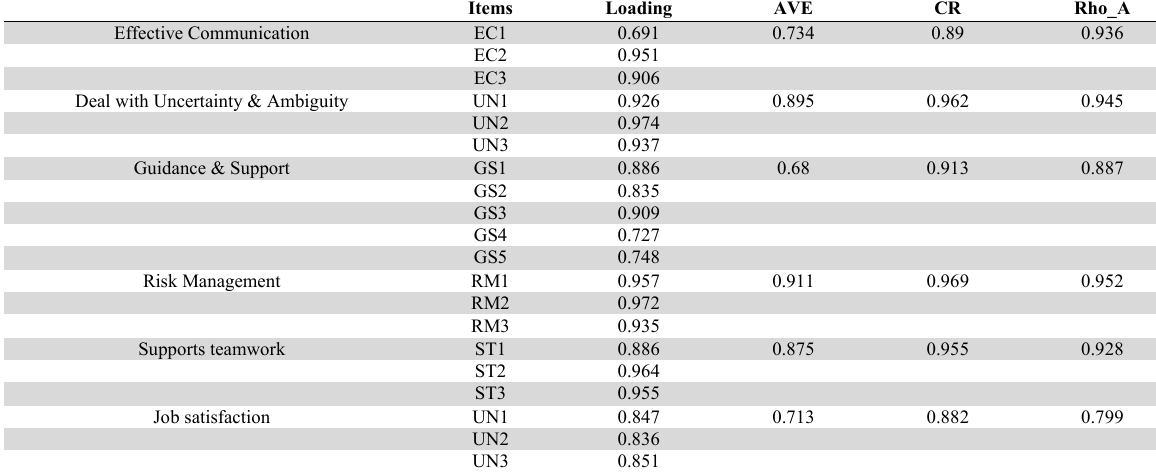
Measurement Model